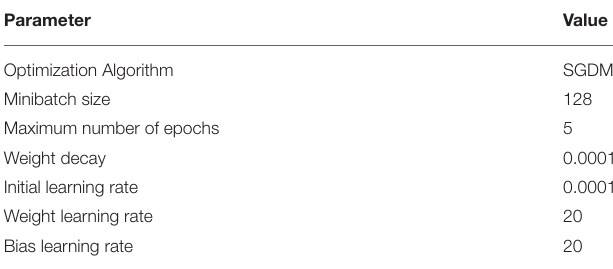
TABLE 1 | Fine-tuning parameters for AlexNet (using Matlab version 2019a).